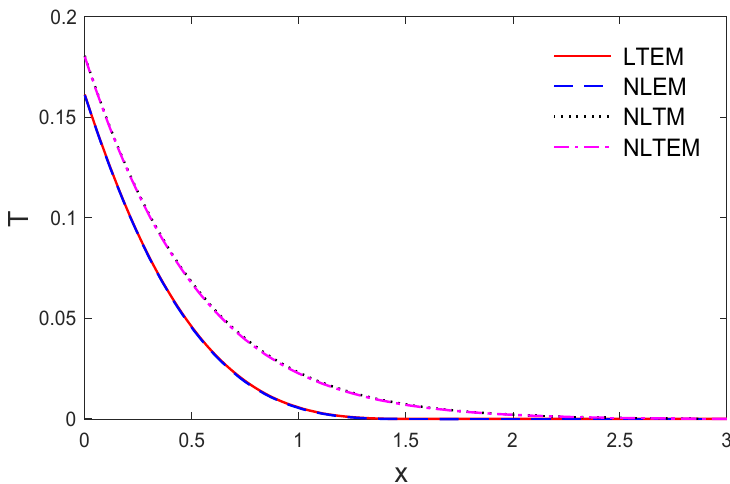
Figure 1. The temperature variations via the distance for four different models. Mathematics 2022 , 10 , x FOR PEER REVIEW